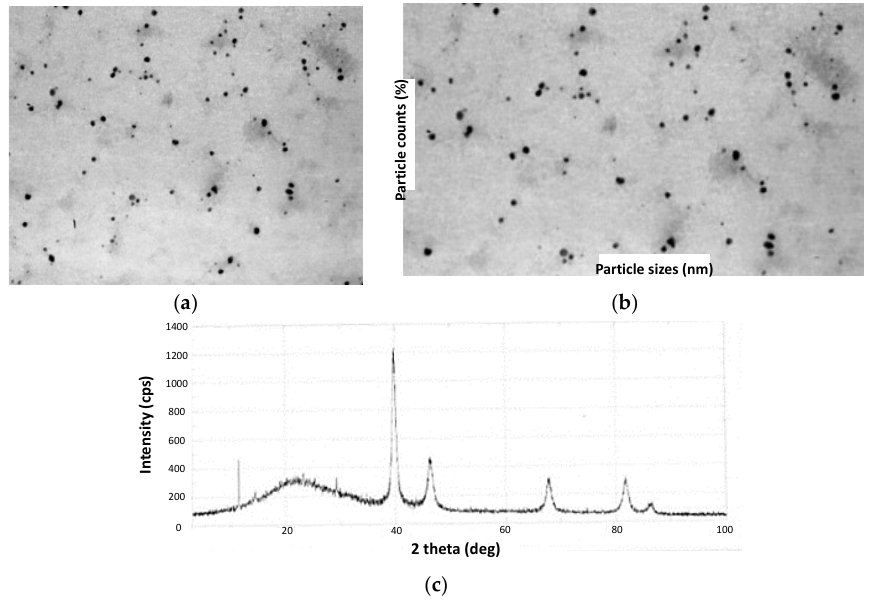
Figure 6. ( a ) TEM image of Kraft lignin PdNPs and ( b ) its statistical distribution of NP dimensions. ( c ) XRD pattern of Kraft lignin PdNPs. Adapted with permission from reference [71]. Copyright 2013 Elsevier B.V.